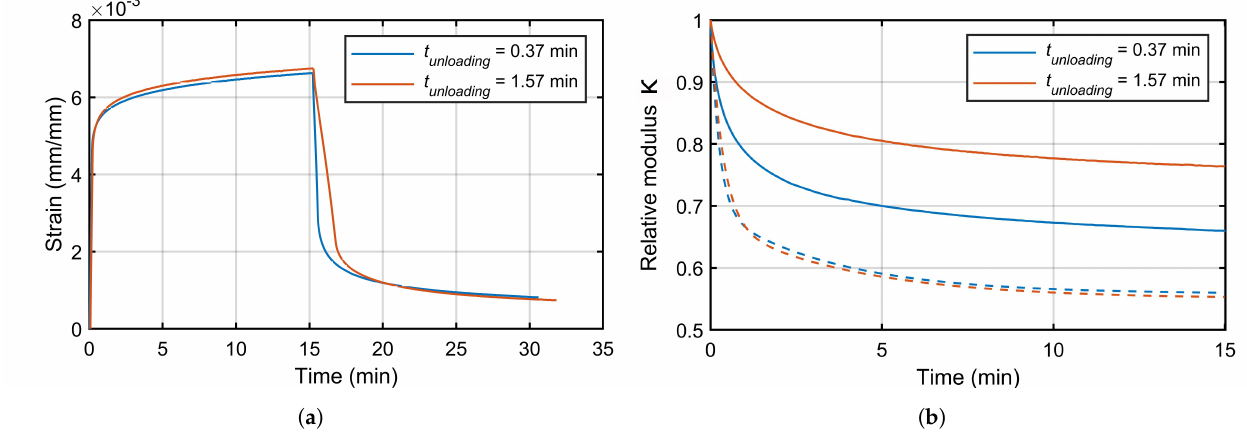
Figure 7. CCRTs with a creep load of 500 N (PA 6): ( a ) registered strain; ( b ) relative modulus κ ( t )